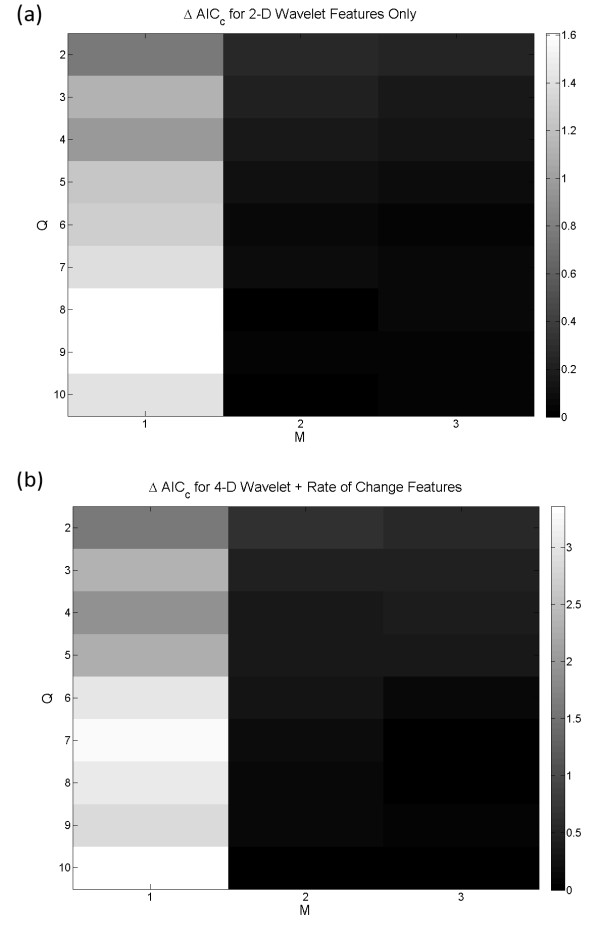
The rescaled AICc values are plotted with respect to the number of HMM states and Gaussian mixtures. (a) The simplest model with ΔAICc < 0.25 is at Q = 3 and M = 2. In this model, the reduced feature space consists of 2-D wavelet coefficients. (b) With the 4-D wavelet and rate of change features established using mRMR, the simplest model with ΔAICc < 0.25 is found at Q = 5, M = 3.